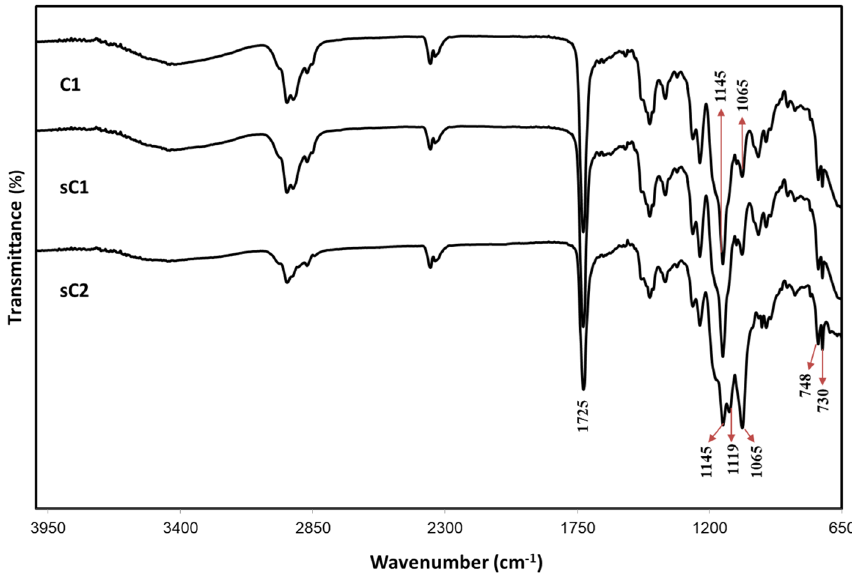
Figure 9. ATR–FTIR spectra of Case III evidence.